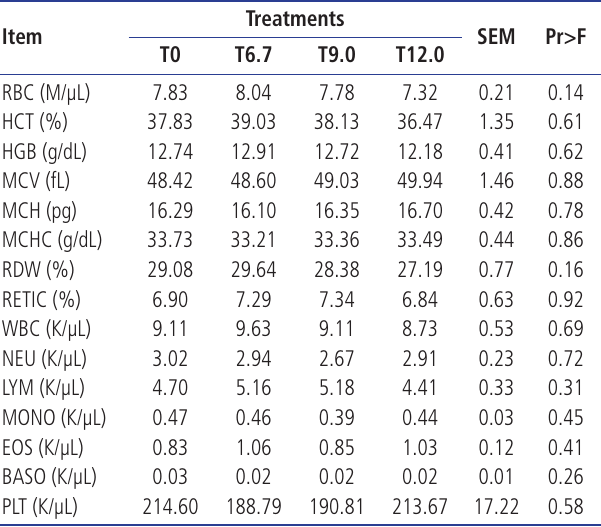
Table 4. Effects of dietary levels of tapioca residue on blood corpuscle parameters in late fattening Hanwoo steers Treatments Item